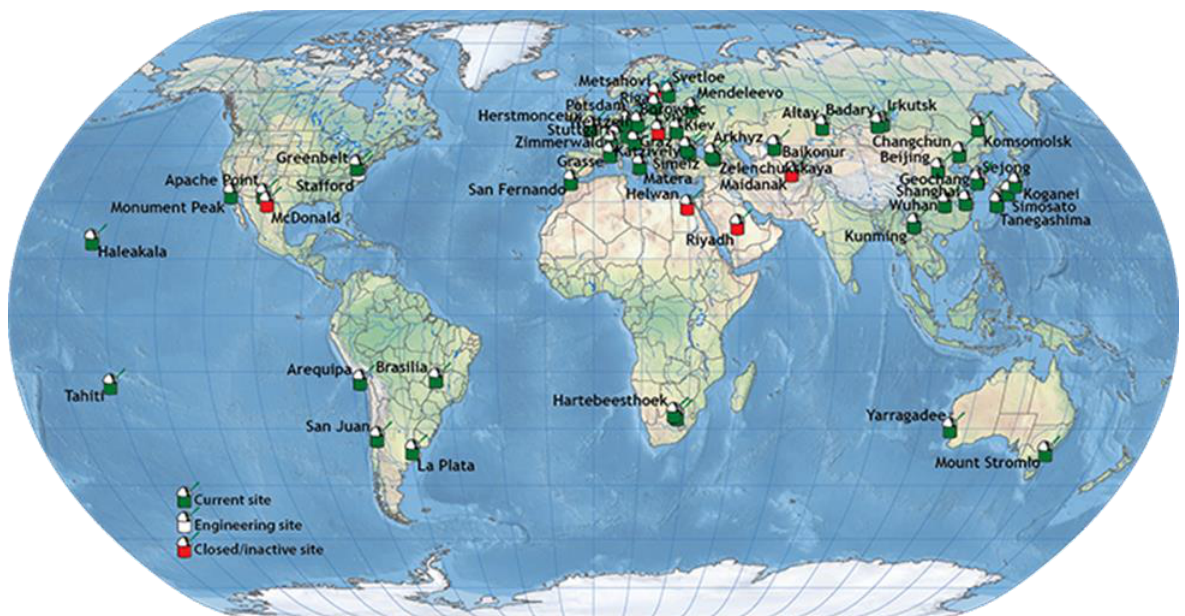
Figure 1. Current global distribution of SLR stations in the ILRS Network.